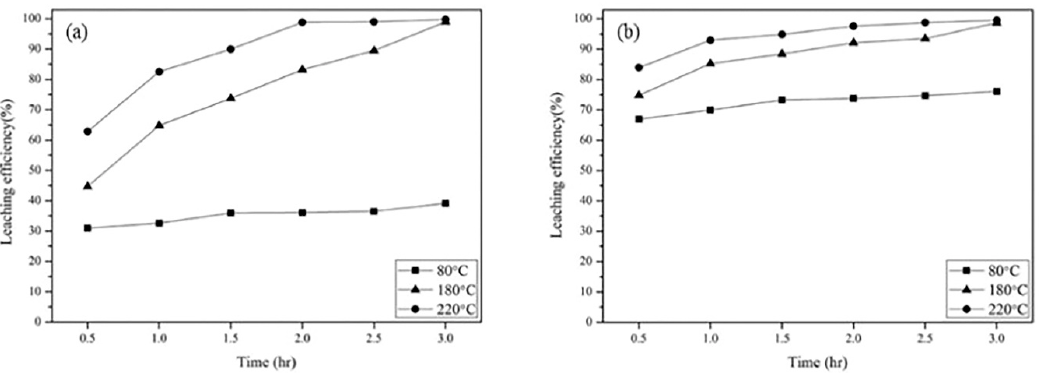
Figure 6. ( a ) E ff ect of the reaction time at di ff erent temperatures on Ta leaching e ffi ciency. ( b ) E ff ect of the reaction time at di ff erent temperatures on Mn leaching e ffi ciency. Concentration: 5 % v / v . Liquid–solid ratio: 100 mL per